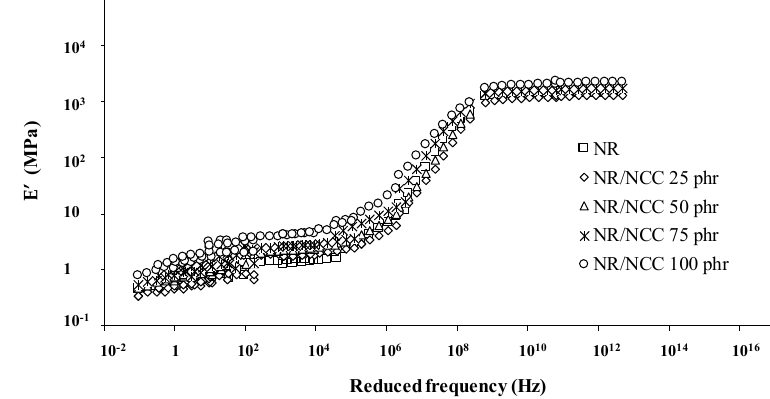
Figure 12. Elastic modulus (E’) versus reduced frequency master curves for pure NR and NR/MCC composites. Insert figure presents raw data of pure NR before establishing the master curve.